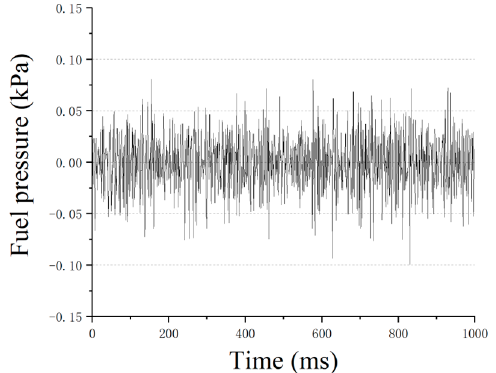
Figure 11. The filtered small − amplitude high − frequency signal.